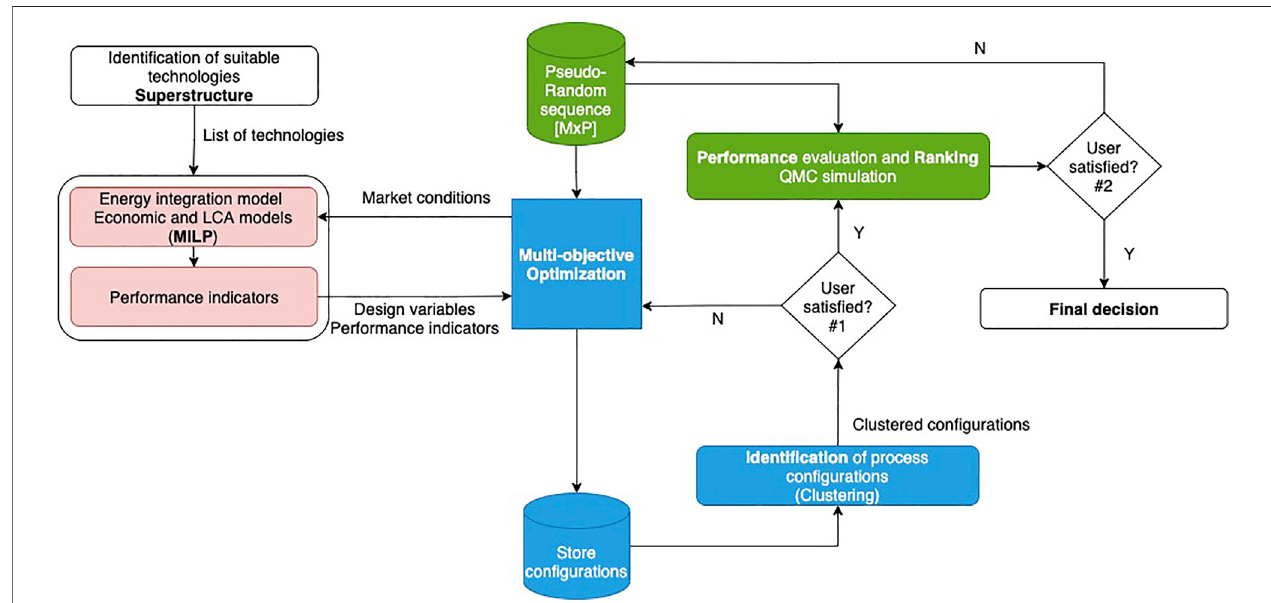
FIGURE 1 | Solution generation procedure; blue and red shapes refer to the master and slave level, respectively. Green shapes are user